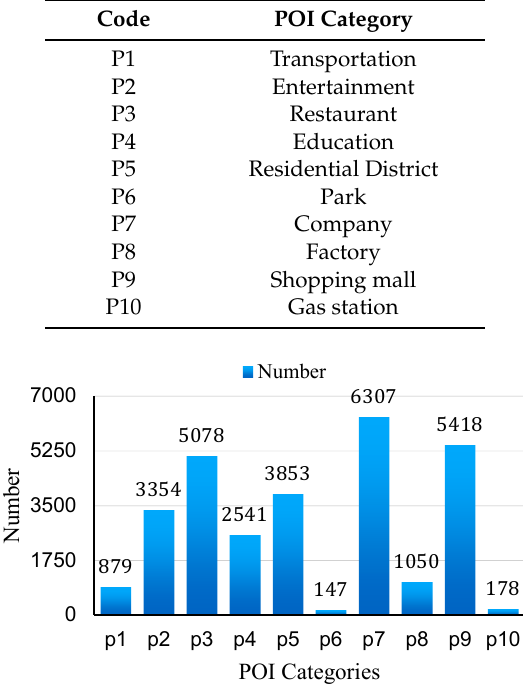
Figure 9. Numbers of POI in Shenyang City.